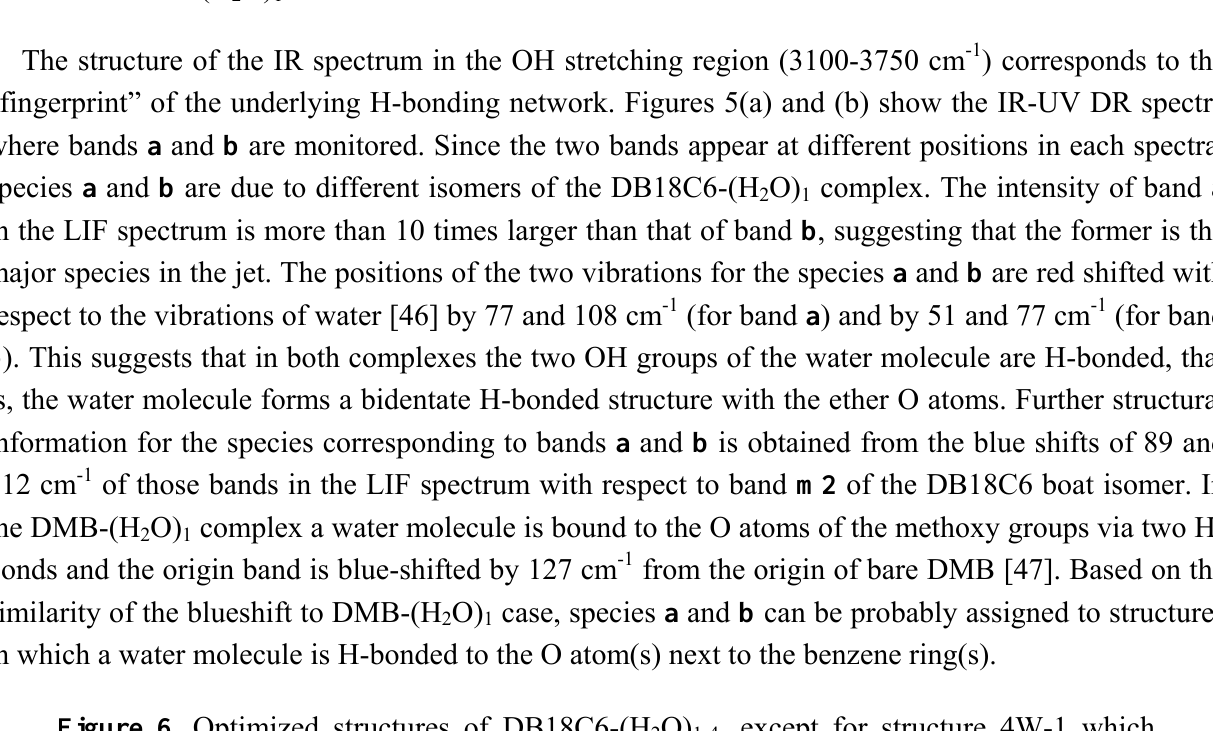
O) , except for structure 4W-1 which 2 1-4